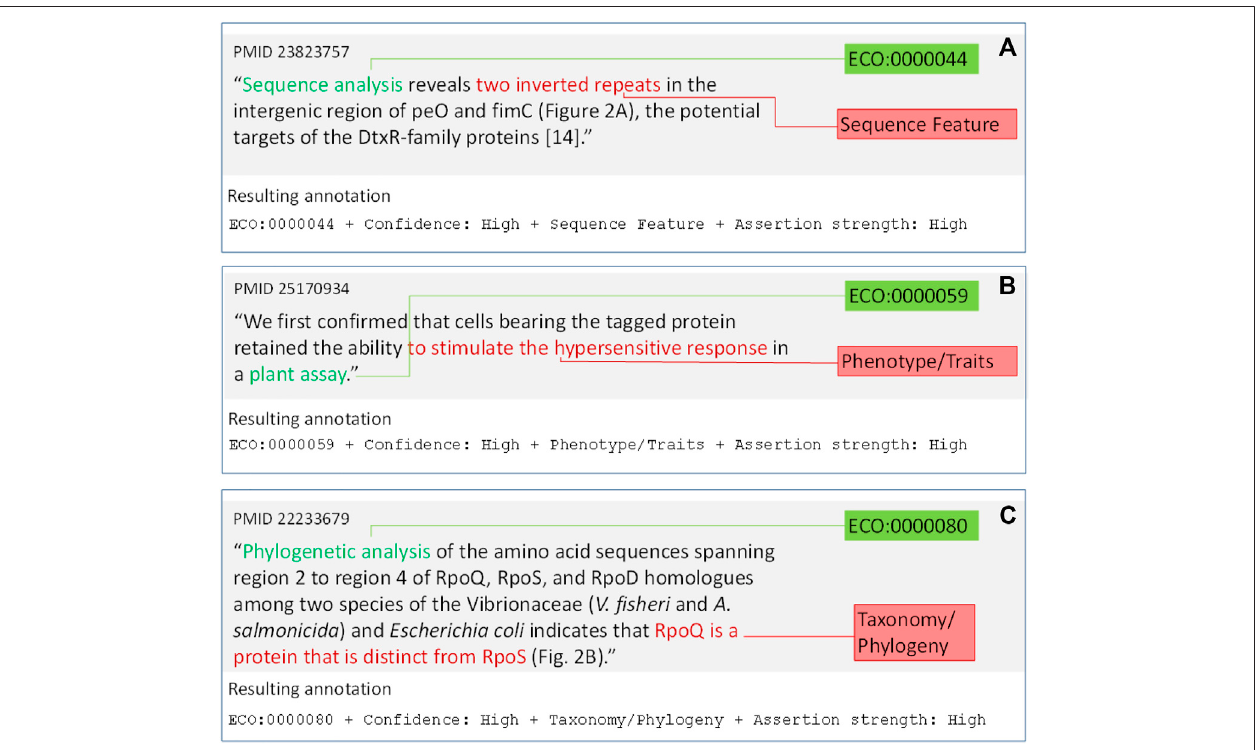
FIGURE 3 | Example annotations with non-gene product annotations. (A) Annotation with Sequence Feature category. (B) Annotation with Phenotype/Traits category. (C) Annotation with Taxonomy/Phylogeny category. Text segments in the sentence mapping to ECO terms (green boxes) are highlighted in green. Text segments indicating the category to annotate (red boxes) are highlighted in red. The ECO term, ECO mapping con fi dence, Category, and Assertion Strength are displayed underneath the annotated